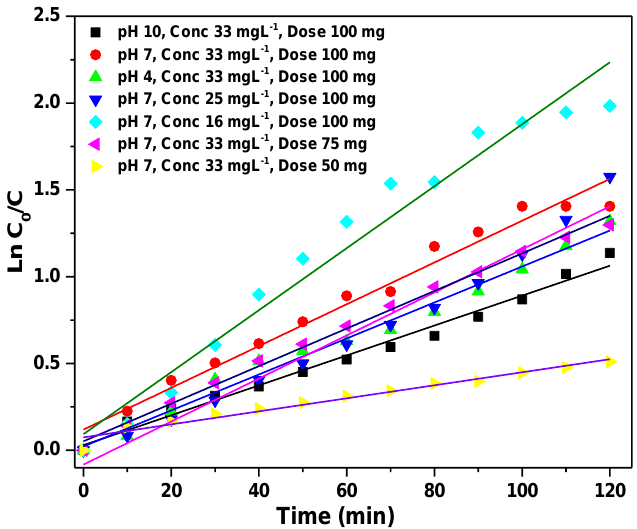
Figure 10. Derivation of the pseudo-first-order rate constants of Ag-4 catalyst at different parameters (pH, p-NP conc., Ag-4 catalyst dose) under visible light by linear regression.